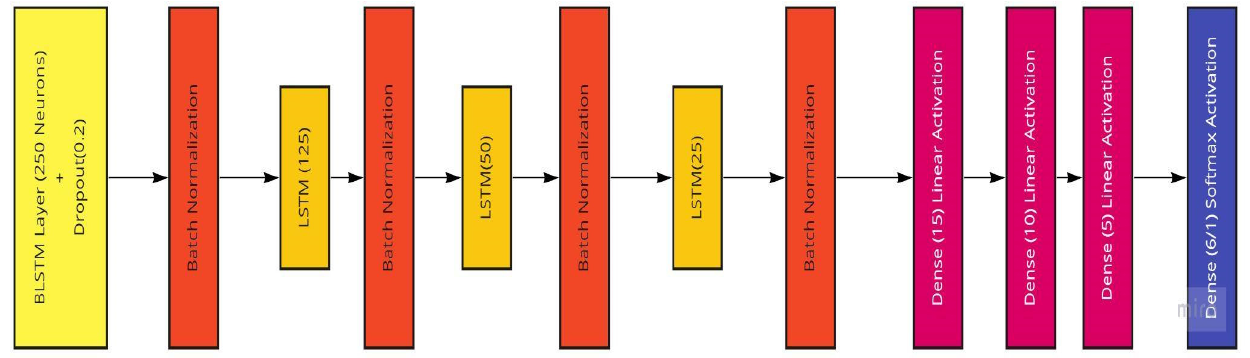
Figure 13. The BLSTM Model utilized featuring a BLSTM and three LSTM layers.